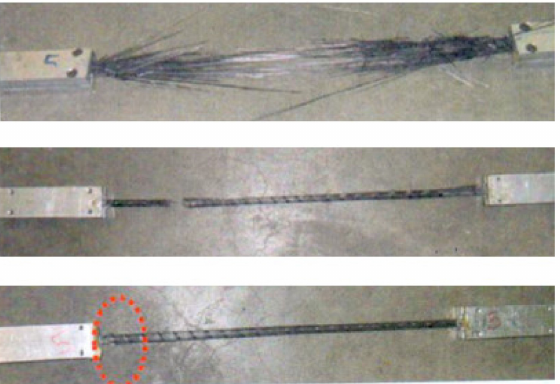
Figure 13. CFRP cable ( φ = 10 mm)—Typical cable configuration after test: specimen 1 (Up); specimen 2 (Center); specimen 5 (Down).